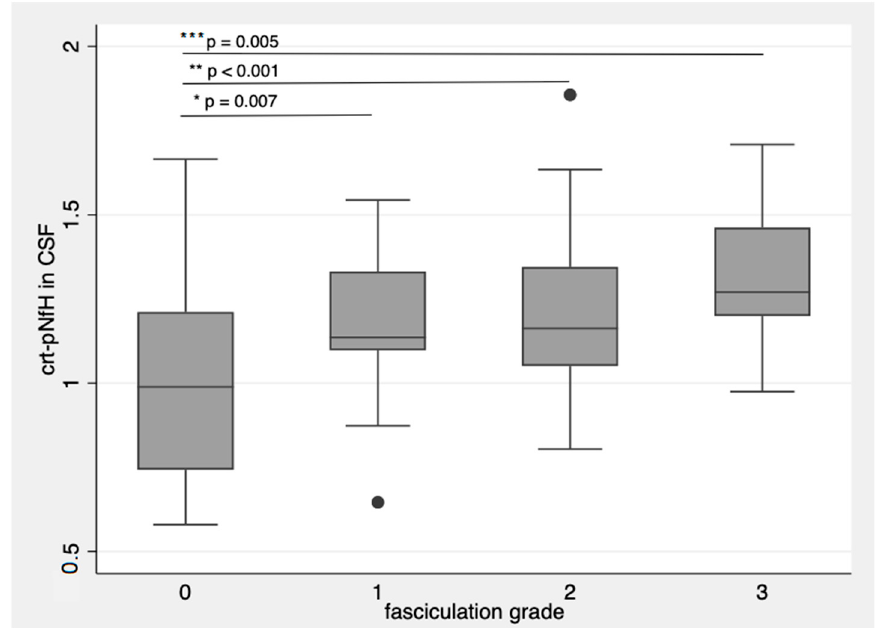
Figure 3. crt-pNfH in CSF concentrations raise with more frequent and diffuse fasciculations. * p - value = 0.007; ** p -value < 0.001; *** p -value = 0.005. Dots are outlier values of crt-pNfH in CSF according to the groups defined by fasciculation grading. The box plots show the crt-pNfH concen- trations (median and interquartile values) according to the grade of fasciculations. 0: no observable or sporadic fasciculations, 1: single fasciculation observed in one muscle, 2: focal fasciculations, localized in one muscular district, 3: for multifocal continuous fasciculations.